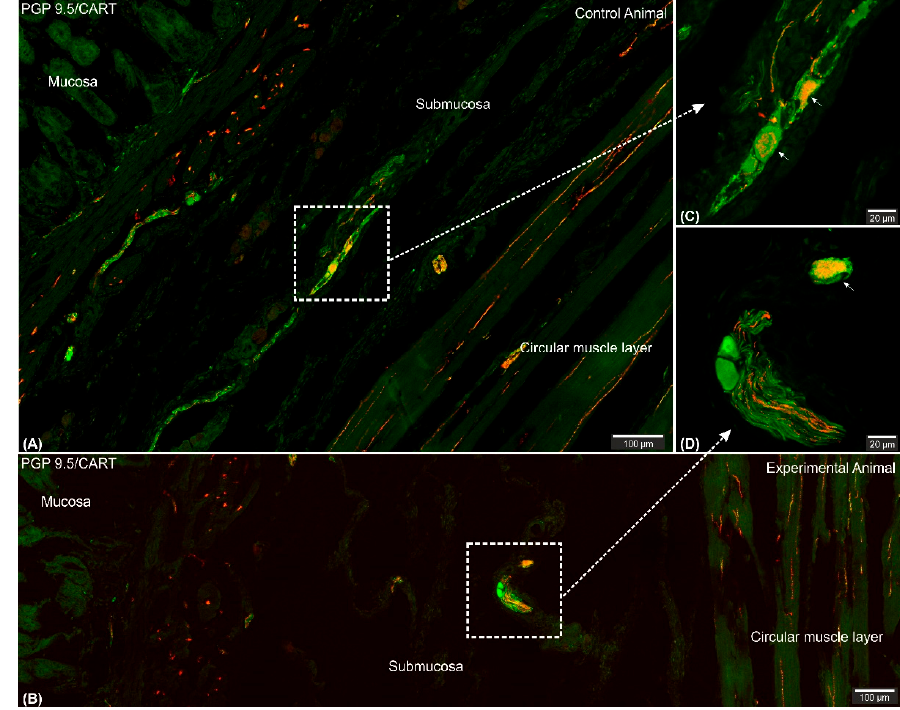
Figure 2. Set of exemplary figures showing submucosal PGP 9.5/CART double immunofluorescent perikarya (arrows) sporadically observed in the control ( A , C ) and experimental ( B , D ) pigs. ( A , B ) Figures showing large area of the stomach wall (mucosa, submucosa, and deeper part of the circular muscle layer) created using the confocal ‘tilt’ function to visualize the exact location of submucosal perikarya. ( B , D ) Higher magnification of submucosal perikarya. Both channels (red—CART staining, green—PGP 9.5 staining) overlapped in the pictures. Scale bars included in the